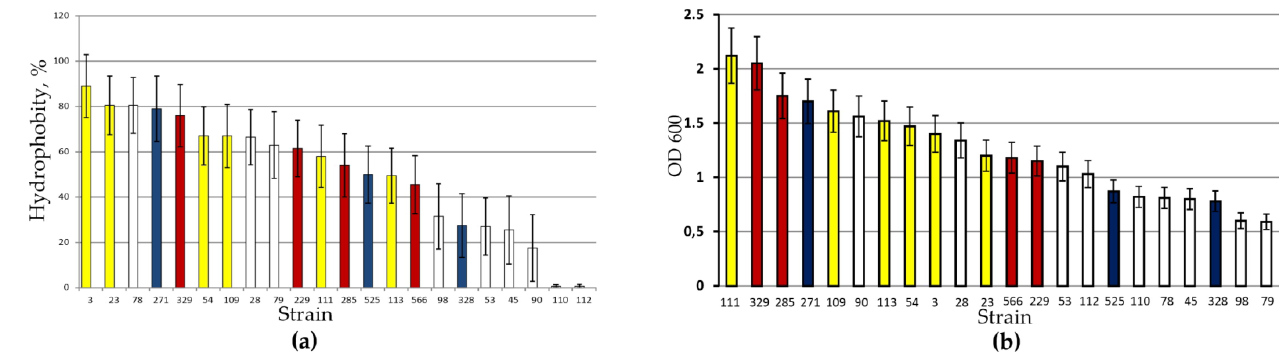
Figure 3. Adhesive properties of yeast strains. ( a ) Isooctane test; ( b ) adhesion to polystyrene. Flor strains are shown in red, wine strains — in blue, environmental isolates able of forming a flor (indicated by +++ in Table 1) in yellow, other environmental isolates — in open bars. On top bars show standard deviation